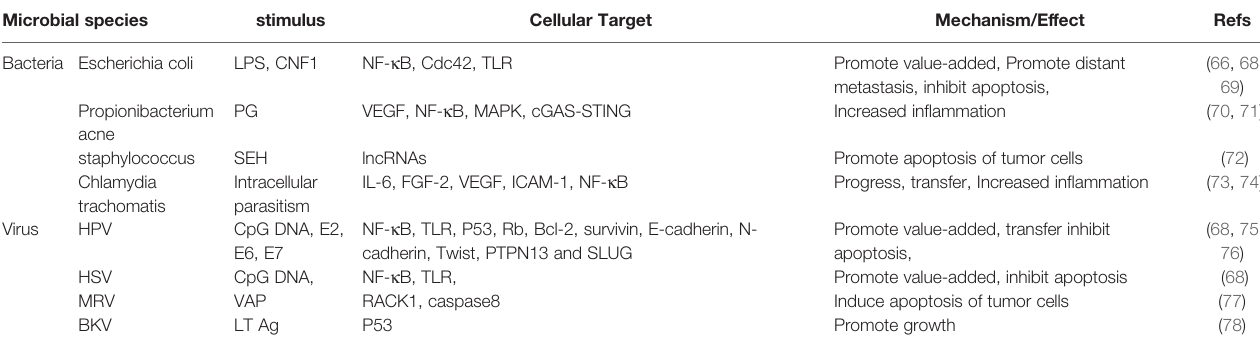
TABLE 1 | Study on the pathways related to the carcinogenesis of some microorganisms. Microbial